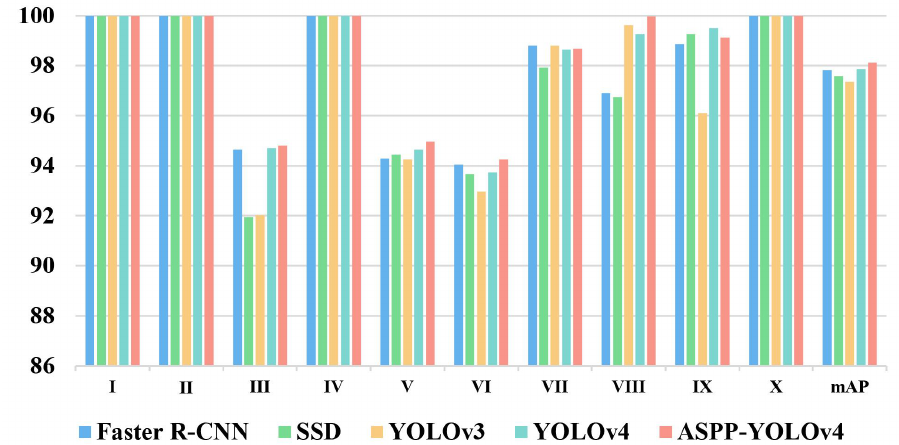
Figure 12. Statistical plots of the AP values of the ten point symbols in Table 1 identified using different